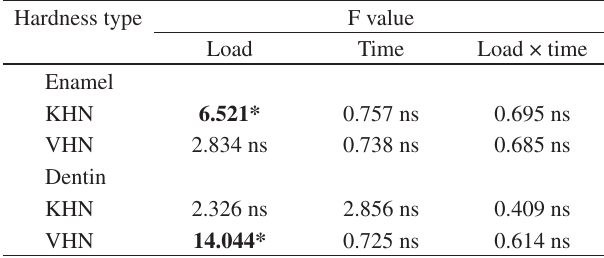
Table 1. Results of two-way ANOVA. Hardness